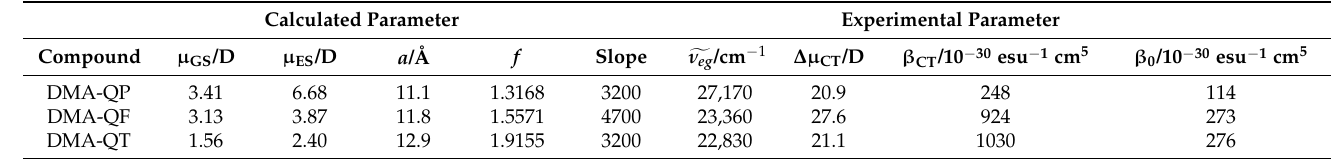
Figure 4. Linear plots of the Stokes shift vs. solvent properties (dielectric constant, ε , and refractive index, n ) of the investigated compounds (DMA-QP ( left ), DMA-QF ( middle ), DMA-QT ( right )). Table 2. Predicted and experimental data required for the determination of the dynamic ( β CT ) and static ( β 0 ) hyperpolarizability coefficients of the investigated compounds in Tol: ground state dipole moment ( µ GS ); excited-state dipole moment ( µ ES ); Onsager’s cavity ray ( a ); dipole moment difference ( ∆ µ CT = µ ES − µ GS ); absorption maximum frequency ( (cid:102) v eg ); theoretical oscillator strength ( f ). In the case of DMA-QT, the distance between the barycenter of the two poles ( d = 8.00 Å) is also used as the double dipole model is